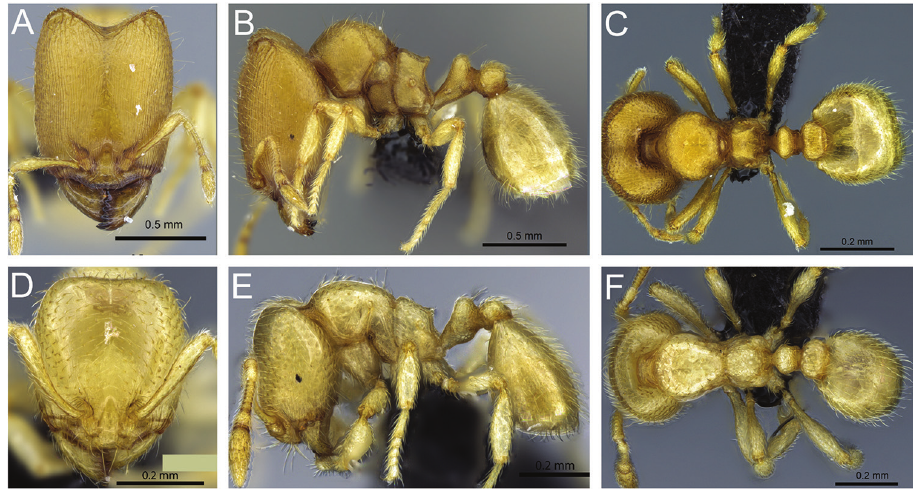
Figure 43. Carebara jajoby –holotype. Major worker, CASENT0037505: A head in full-face view B body in profile view C body in dorsal view. Minor worker, CASENT0037501: D head in full-face view E body in profile view F body in dorsal